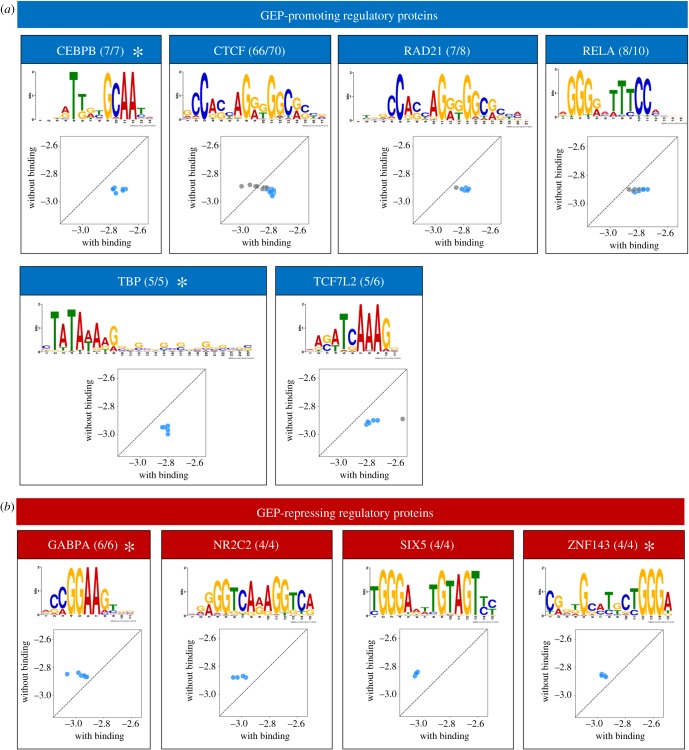
Influence of regulatory proteins on GEP. GEP-promoting (a) and -repressing proteins (b) were defined as those whose target genes exhibited significantly (Mann–Whitney U-test, Benjamini–Hochberg corrected p < 0.01) higher or lower GEP than other genes. The figure shows the regulatory protein name, the number of samples with significant GEP association, the total samples examined and the preferential binding motif as defined by Factorbook [26]. Star indicates that the protein-binding result is consistent with that from motif analysis. Scatterplot compares GEP between genes with (X-axis) and without (Y-axis) binding in the promoter region (from −500 to +500 relative to the TSS) of regulatory proteins having a promoting (a) or repressive (b) role. Blue indicates p < 0.01 (Mann–Whitney U-test, Benjamini–Hochberg corrected).